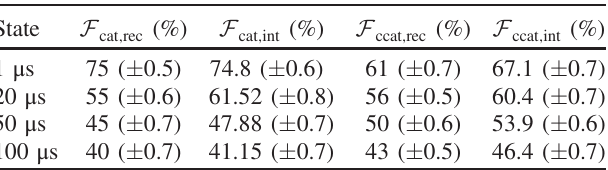
TABLE V. Comparison of fidelities extracted from density matrix reconstruction ( F ) and direct integration of character- cat ; rec istic function ( F cat ; int